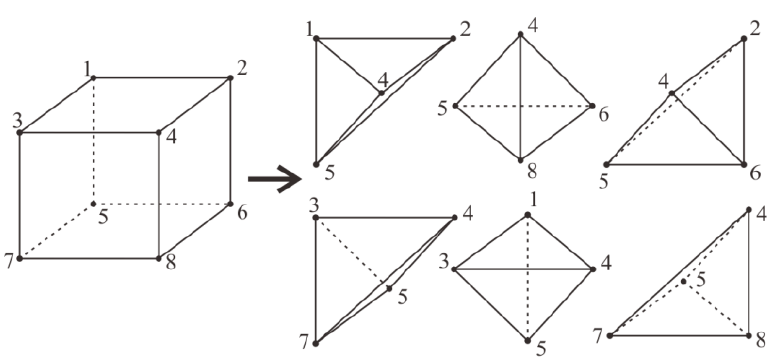
Figure 11. Hexahedron subdivided into tetrahedrons.